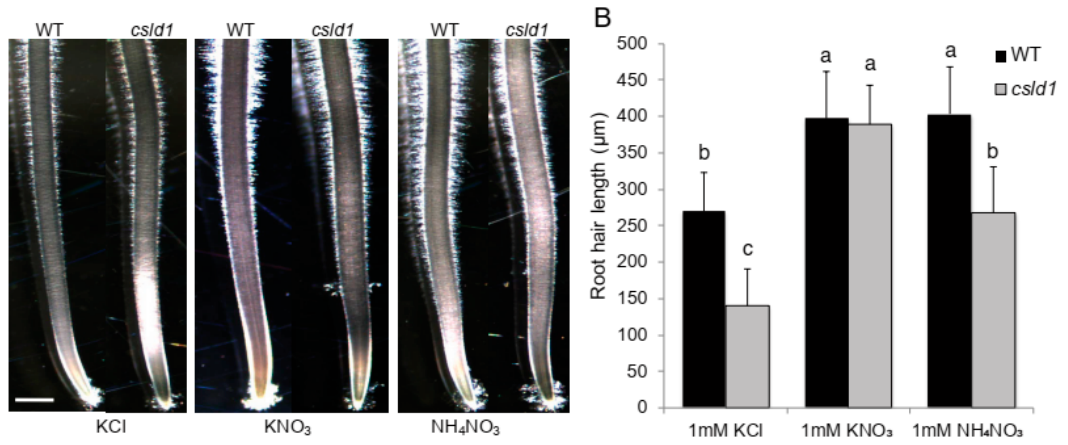
Figure 3. csld1 root hair failed to elongate in the presence of NH 4+ . ( A ) Seminal roots of wild-type and csld1 mutants grown in 1 mM KCl, KNO 3 , and NH 4 NO 3 , respectively, and ( B ) quantification of root hair length. Scale bars = 500 μ m. Bar graph show mean values ± standard error of means ( n = 8). Different letters indicate significant differences between groups according to Tukey’s HSD test ( p < 0.05).